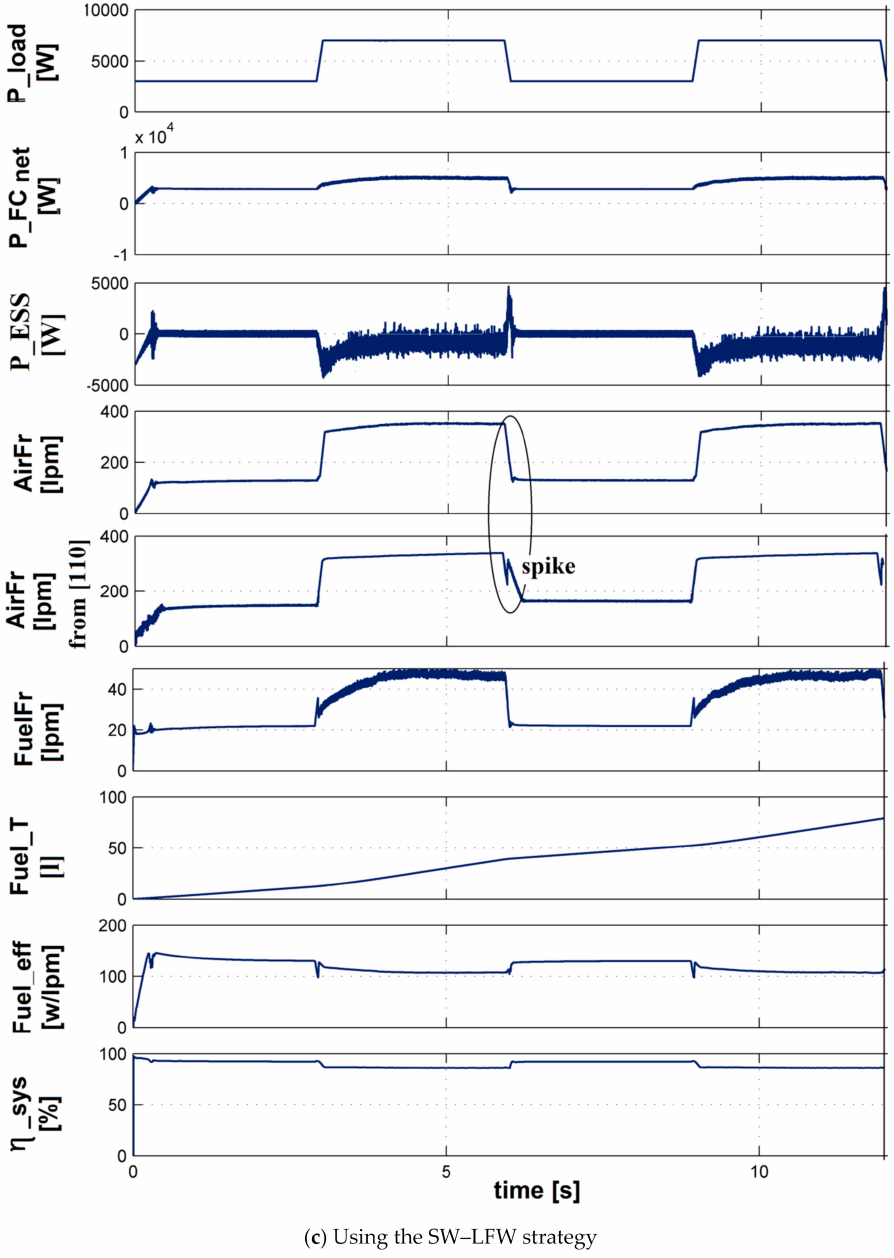
Figure 6. Behavior of the FCHPS under the second load profile (3/7 kW load